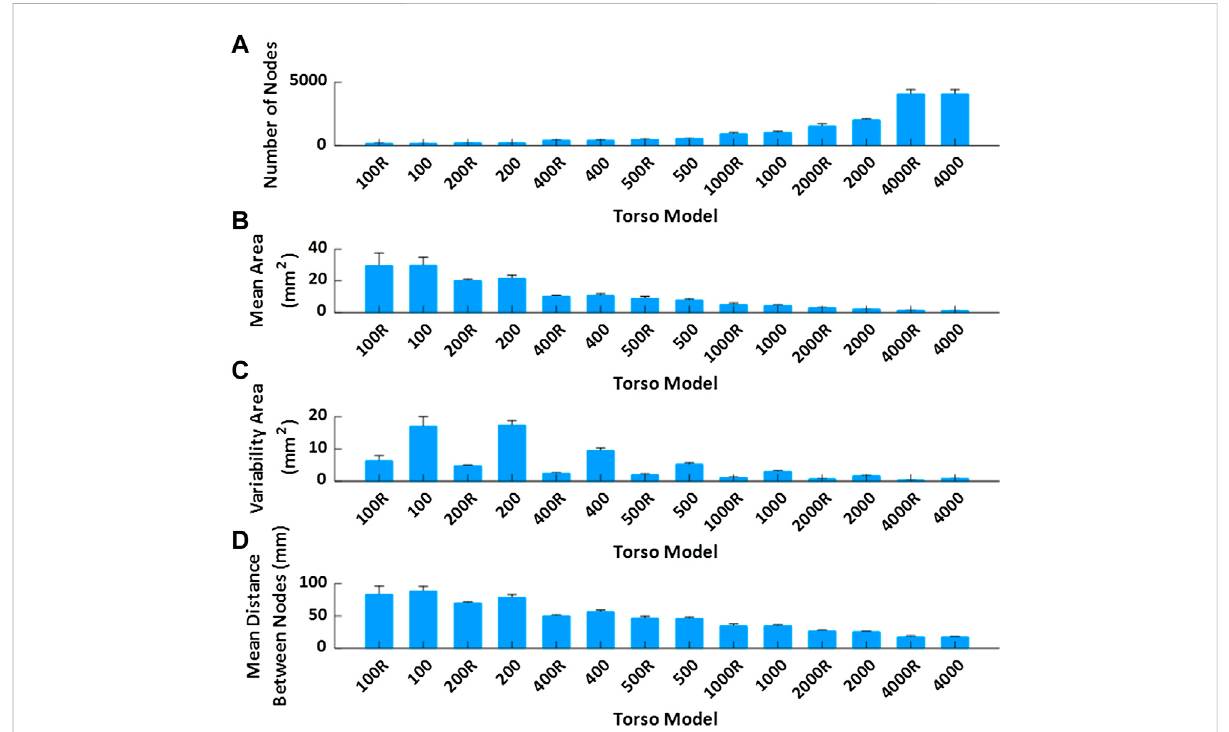
FIGURE 2 Mean value and standard deviation of torso model properties of the geometries used in the simulation study represented. (A) . Mean number of nodes depending on the model. (B) . Mean area of the faces. (C) . Variability of the area of the faces. (D) . Mean distance between nodes of the same